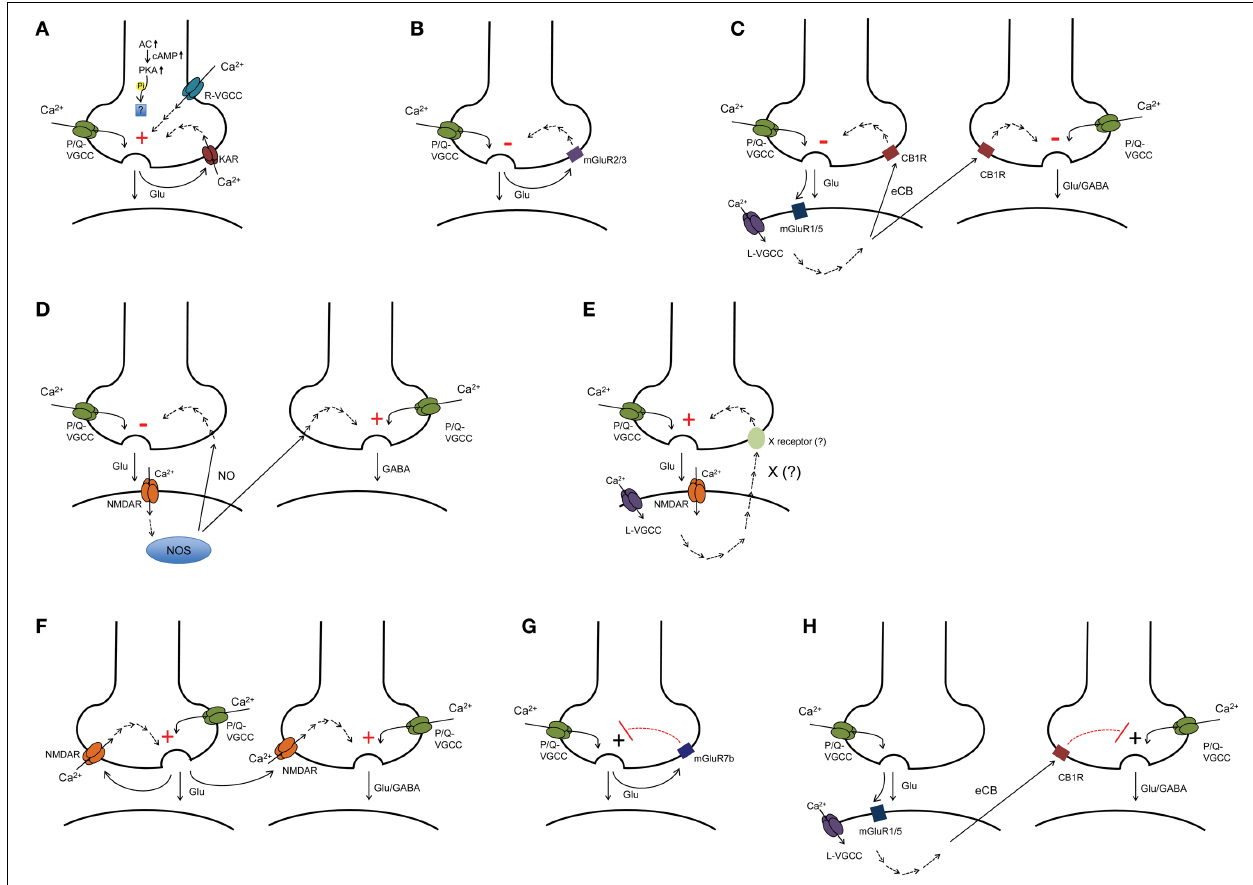
LTP gated by mGluR7b at mossy fiber-SLIN synapses. (H) presynaptic LTP gated by CB1R (e.g., LTP at thalamic-LA synapses). AC, adenylate cyclase; cAMP, cyclic adenosine monophosphate; PKA, protein kinase A; VGCC, voltage-gated calcium channel; KAR, kainate receptor; mGluR, metabotropic glutamate receptor; eCB, endocannabinoid; CB1R, cannabinoid receptor type 1; NO, nitric oxide; NOS, nitric oxide synthase; CP-AMPAR SLIN, calcium permeable-AMPA receptor containing stratum lucidum